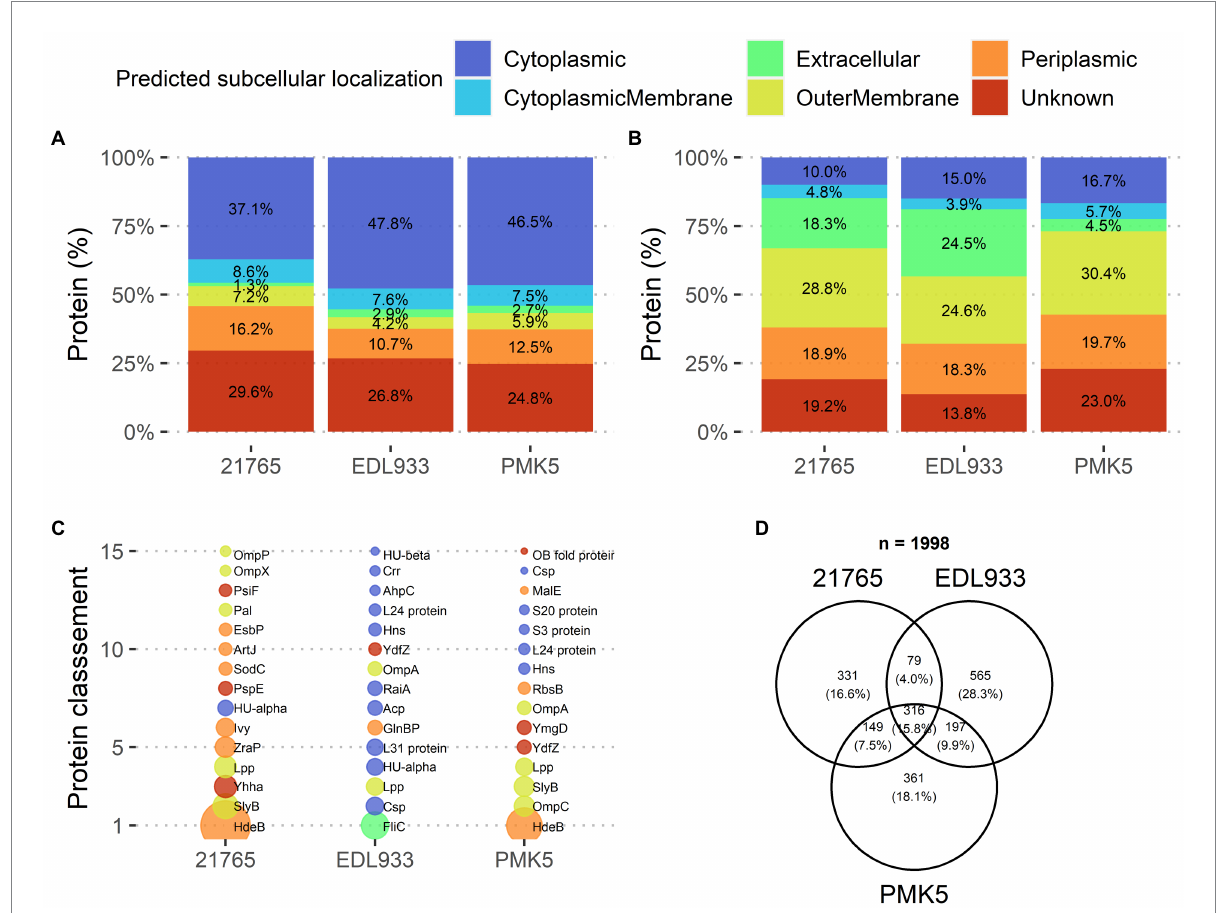
FIGURE 4 Qualitative description of surface protein extracts of STEC O26:H11 str. 21,765, O157:H7 str. EDL933, and O103:H2 str. PMK5, analyzed by MS/MS. (A) Distribution of identified proteins based on subcellular localization prediction for each strain (top left). (B) Distribution of identified proteins for each strain according to the relative protein abundance (NSAF) normalized to the number of identified proteins in the corresponding subcellular localization group (top right). (C) Ranking of the 15 predominant proteins identified in protein extracts for each strain according to relative abundance (NSAF) (bottom left). The bubble size is proportional to the relative abundance value. (D) Venn diagram of the identified proteins according to the strain (bottom right). Acp, acyl carrier protein; AhpC, peroxiredoxin; ArtJ, arginine ABC transporter substrate-binding protein; Crr, Glucose-specific enzyme IIA component of PTS; Csp, cold shock-like protein; EsbP, extracellular solute-binding protein 3; FliC, flagellin; GlnBP, glutamine-binding periplasmic protein (GlnBP); HdeB, acid stress chaperone HdeB; Hns, DNA-binding protein; HU-alpha, DNA-binding protein HU-alpha; HU-beta, DNA-binding protein HU-beta; Ivy, C-lysozyme inhibitor; L24 protein, 50S ribosomal protein L24; L31 protein, 50S ribosomal protein L31; Lpp, major outer membrane lipoprotein Lpp; MalE, maltodextrin-binding protein; OB fold protein, bacterial OB fold family protein; OmpA, outer membrane protein A; OmpC, gram-negative porin; OmpP, omptin family outer membrane protease OmpP; OmpX, outer membrane protein X; Pal, peptidoglycan-associated protein; PsiF, phosphate starvation-inducible protein; PspE, phage shock protein E; RaiA, ribosome- associated translation inhibitor RaiA; RbsB, D-ribose transporter subunit RbsB; S20 protein, 30S ribosomal protein S20; S3 protein, 30S ribosomal protein S5; SlyB, outer membrane lipoprotein SlyB; SodC, superoxide dismutase; YdfZ, putative selenoprotein YdfZ; Yhha, uncharacterized protein YhhA; YmgD, YmgD family protein; ZraP, zinc resistance-associated